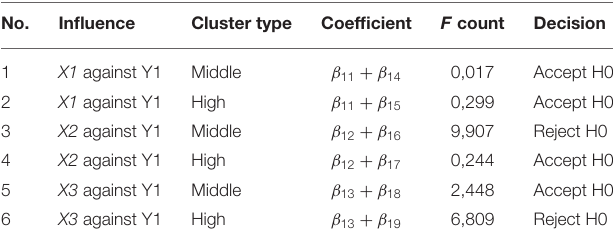
TABLE 9 | Parameter linear function hypothesis (HFLP) direct influence.